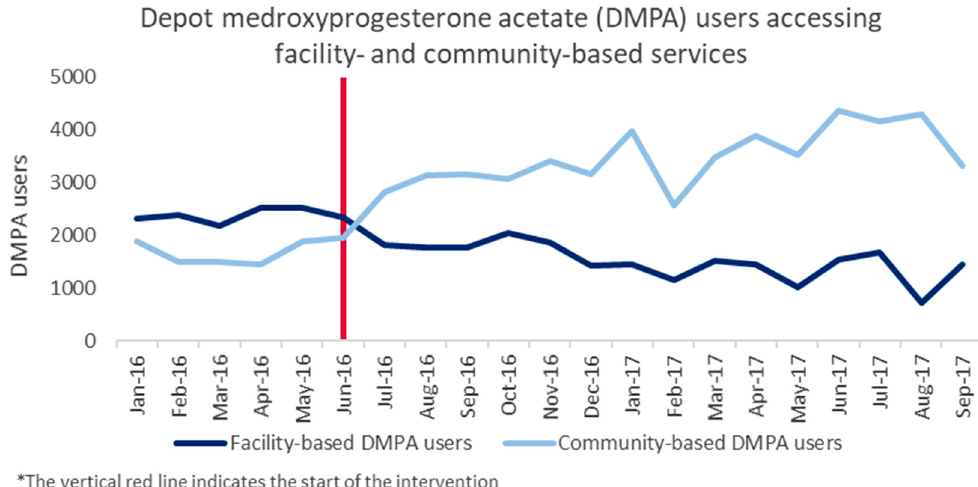
Figure 3. Facility- and community-based depot medroxyprogesterone acetate (DMPA) provision, pre- and postimplementation in Dowa.